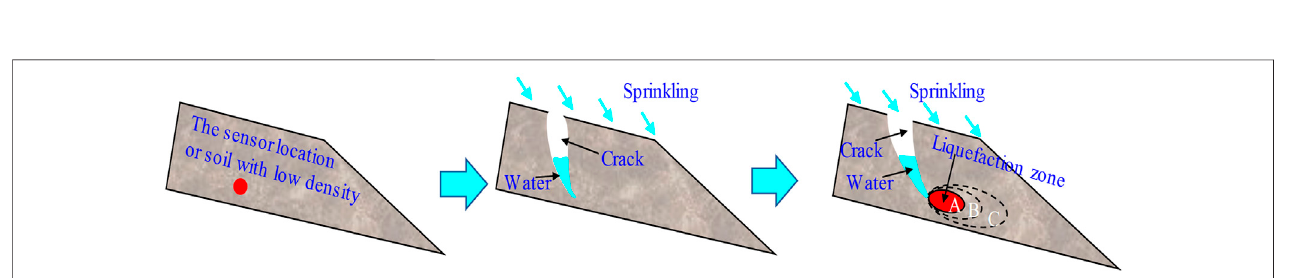
FIGURE 10 | The initiation process of the loess mud fl ows in the tests with slope angles of 10 ° and 13 ° .